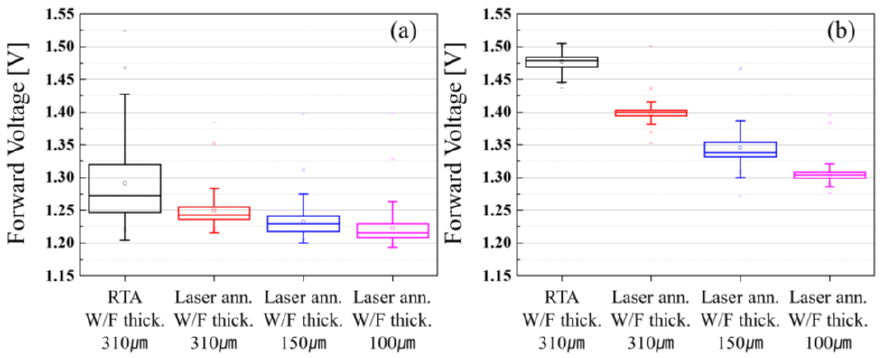
Figure 4. The forward bias properties of fabricated JBS diodes at ( a ) a current of 10A on wafer die chips and ( b ) a current of 20A on TO-220 packages.